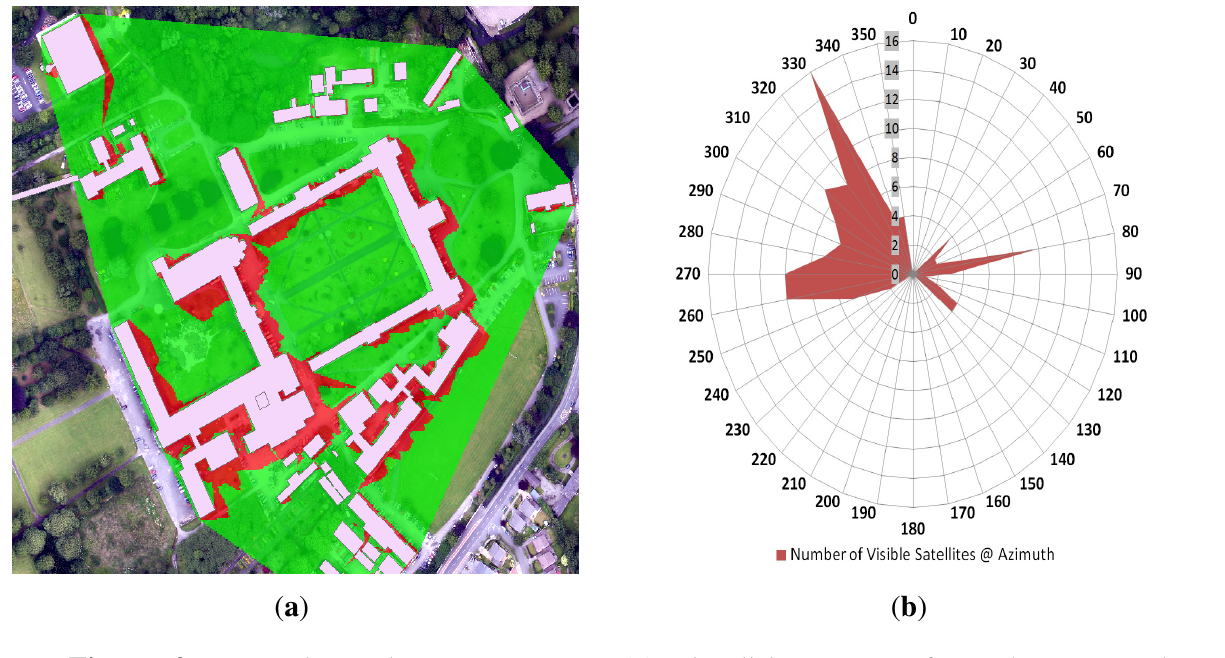
Figure 9. Results and accuracy Tests ( a ) visualising output from the proposed methodology—green areas: visible to four plus satellites, red: less than four satellites ( b ) a plot of satellite azimuths throughout the validations tests—red represents azimuth and number of satellites, grey numbers on Y axis represent total number of satellites visible from the observer location throughout the tests.